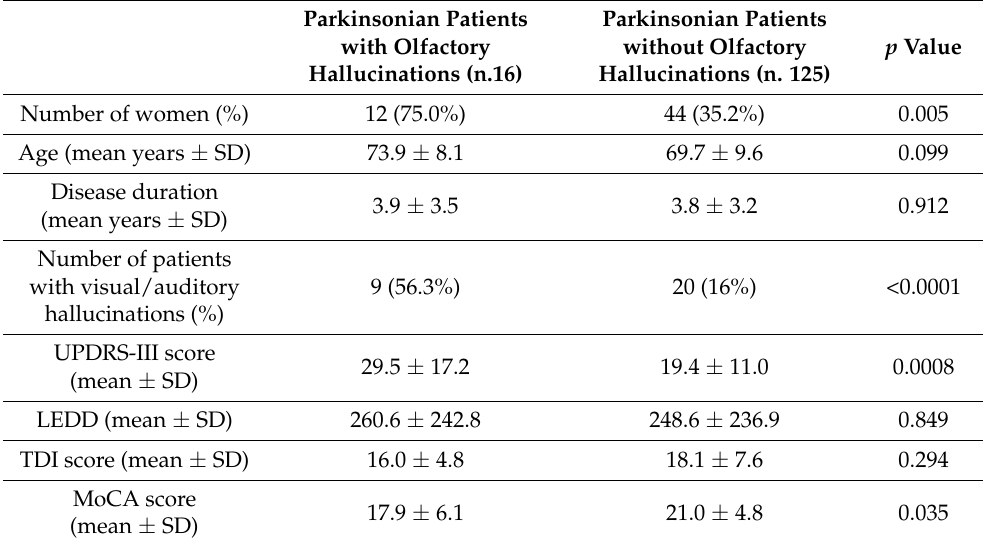
Table 2. Clinical characteristics of PD subjects with or without olfactory hallucinations. Significance was set at the 0.0062 level after Bonferroni